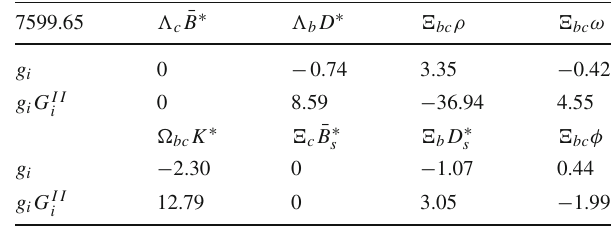
Table 25 Coupling constants to various channels and g i G II with q max = 650MeV